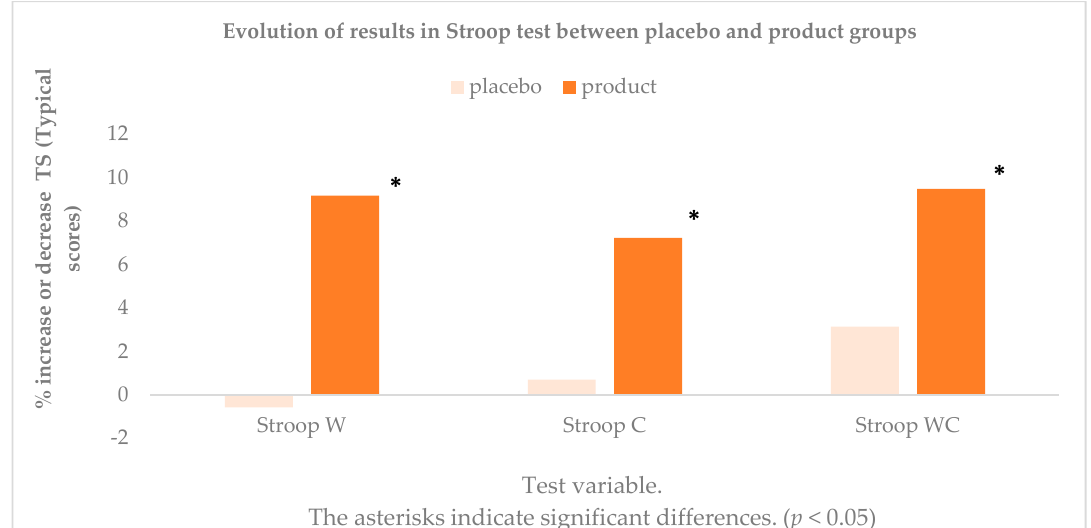
Figure 2. Evolution of results in the different variables of Stroop test in percentage increase or decrease. * indicate significant differences. ( p < 0.05).